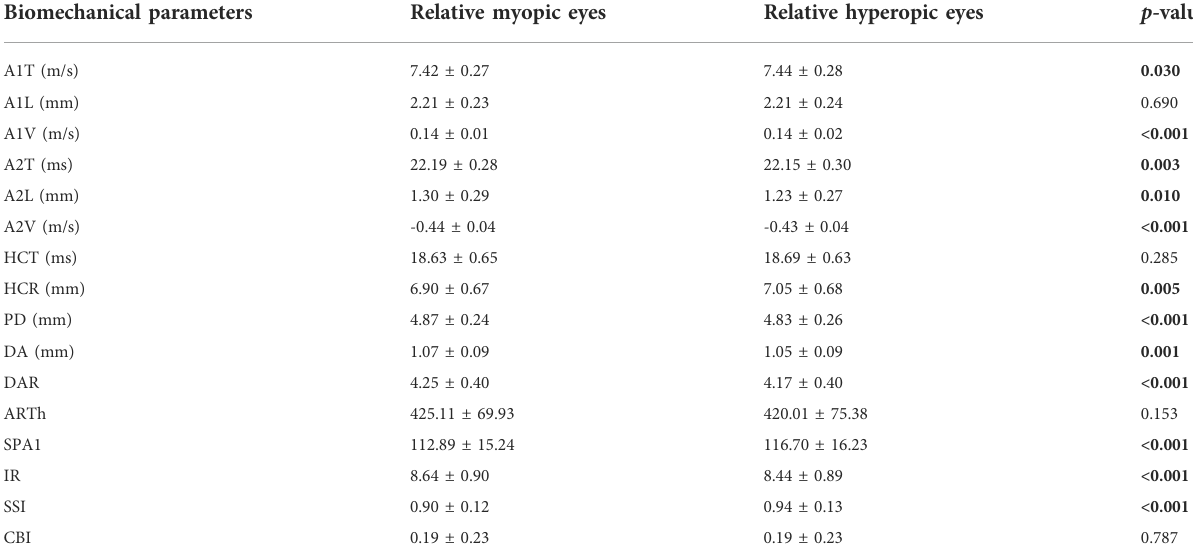
TABLE 4 Comparisons in corneal biomechanical parameters between anisometropic fellow eyes. Biomechanical parameters